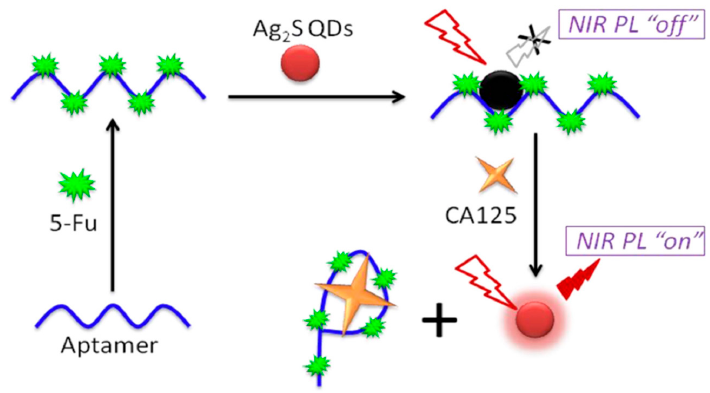
Figure 3. Schematic illustration of the fabrication processes of Ag2S QDs/aptamer/5-Fu hybrid-based near-infrared (NIR) photoluminescence (PL) turn-on probe of CA125. (Reprinted from [45] with permission from Biosensors and Bioelectronics)